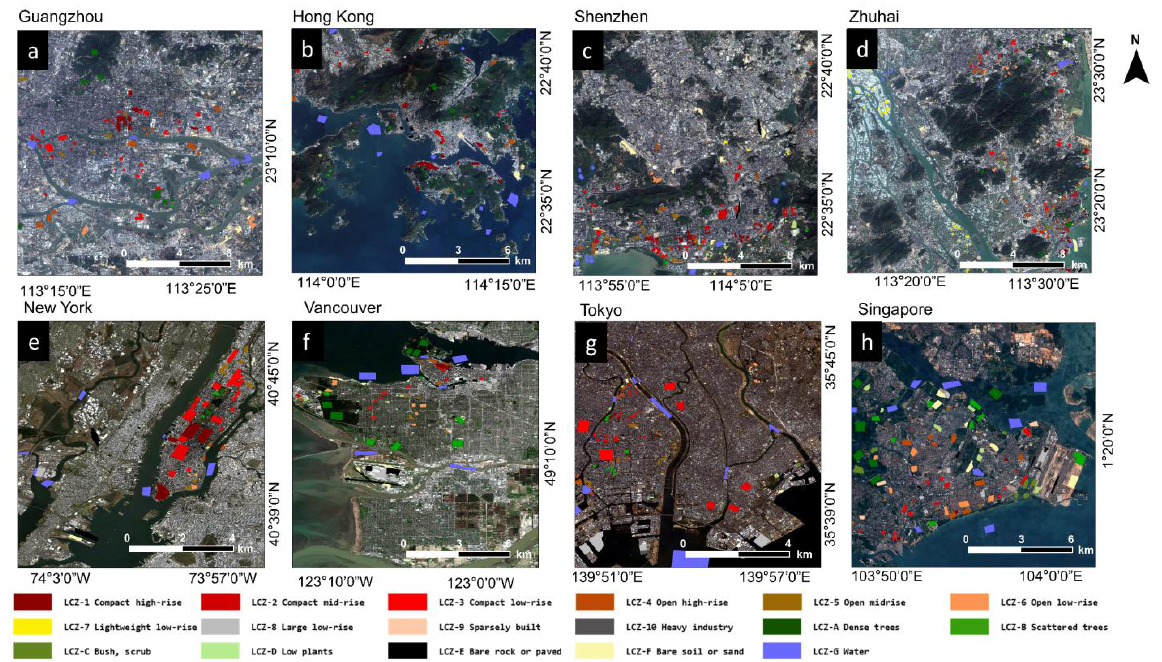
Figure 5. The test sites. ( a – d ) Images and training samples in Guangzhou, Shenzhen, Hong Kong, and Zhuhai, respectively; ( e – h ) Images and validation samples in New York, Vancouver, Tokyo, and Singapore,